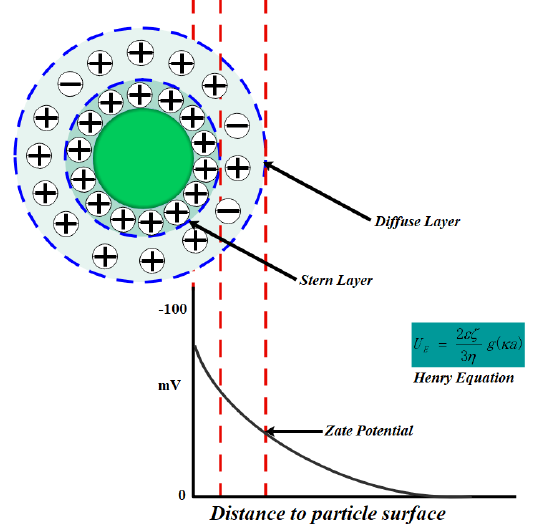
Figure 7. Stern model.